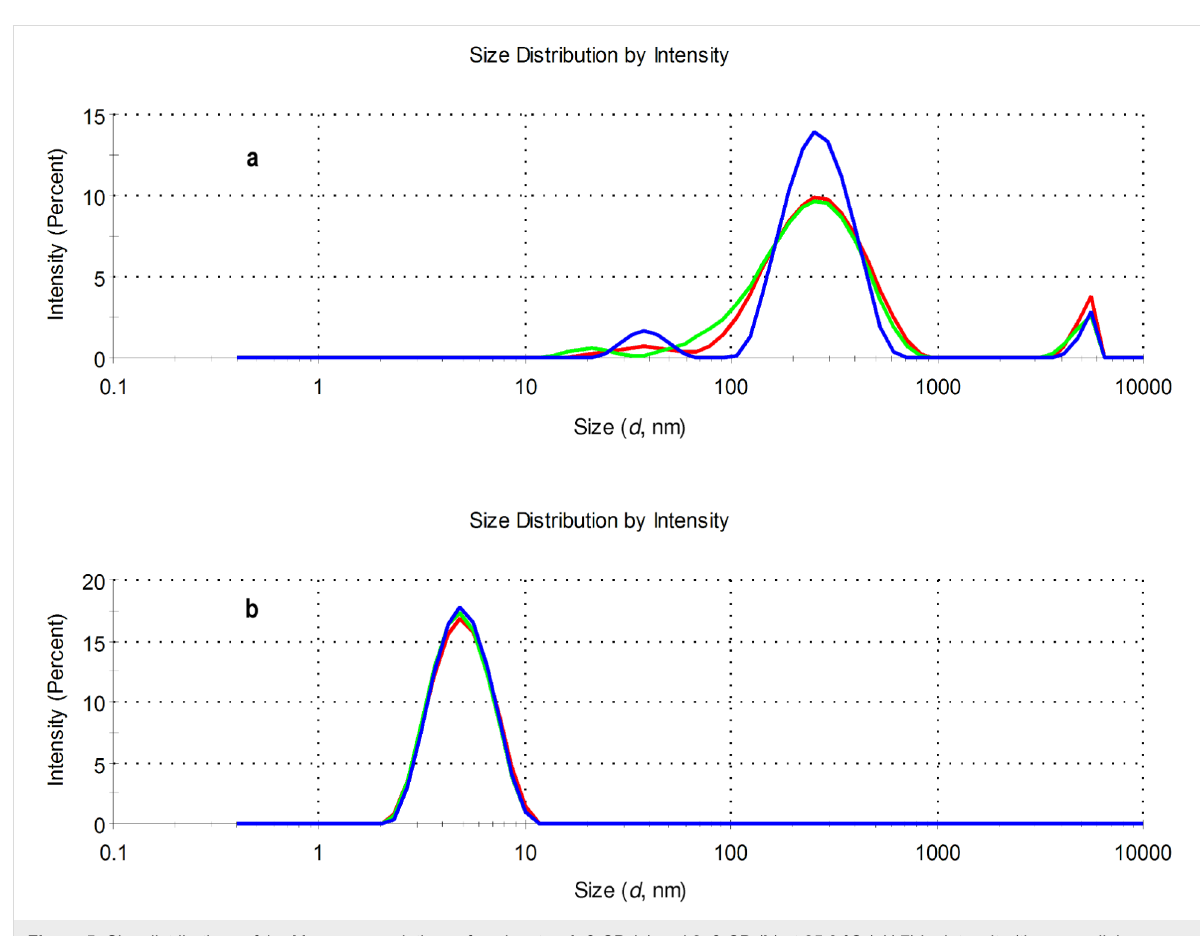
found for cyclodextrin conjugate with dye 4 both in the intensi- ty vs size-distribution plot as well as in the volume plot (see Figure S39 in Supporting Information File